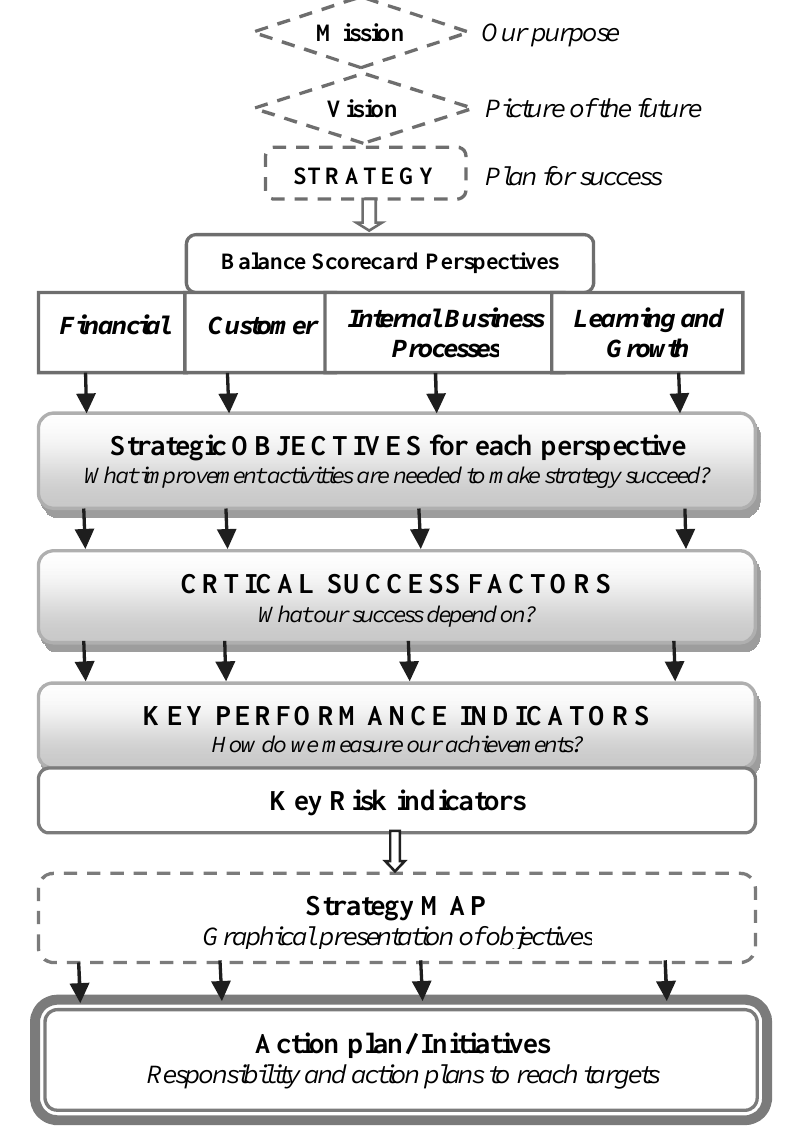
Figure 4 – Model of Balanced